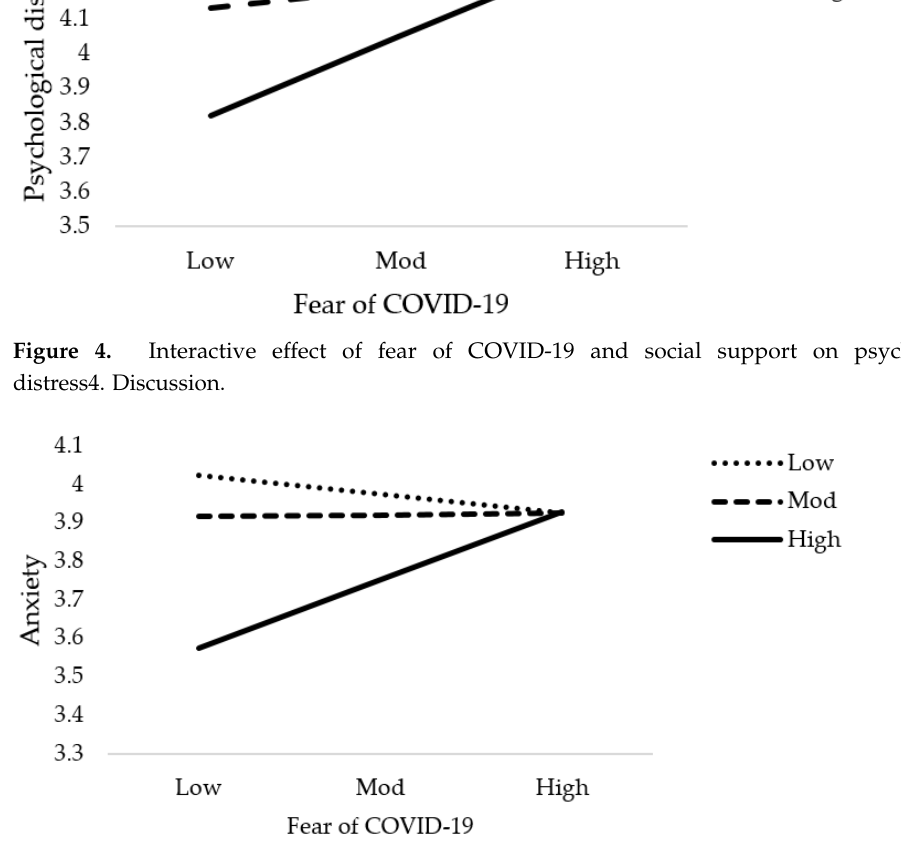
Figure 5. Interactive effect of fear of COVID-19 and social support on Anxiety.